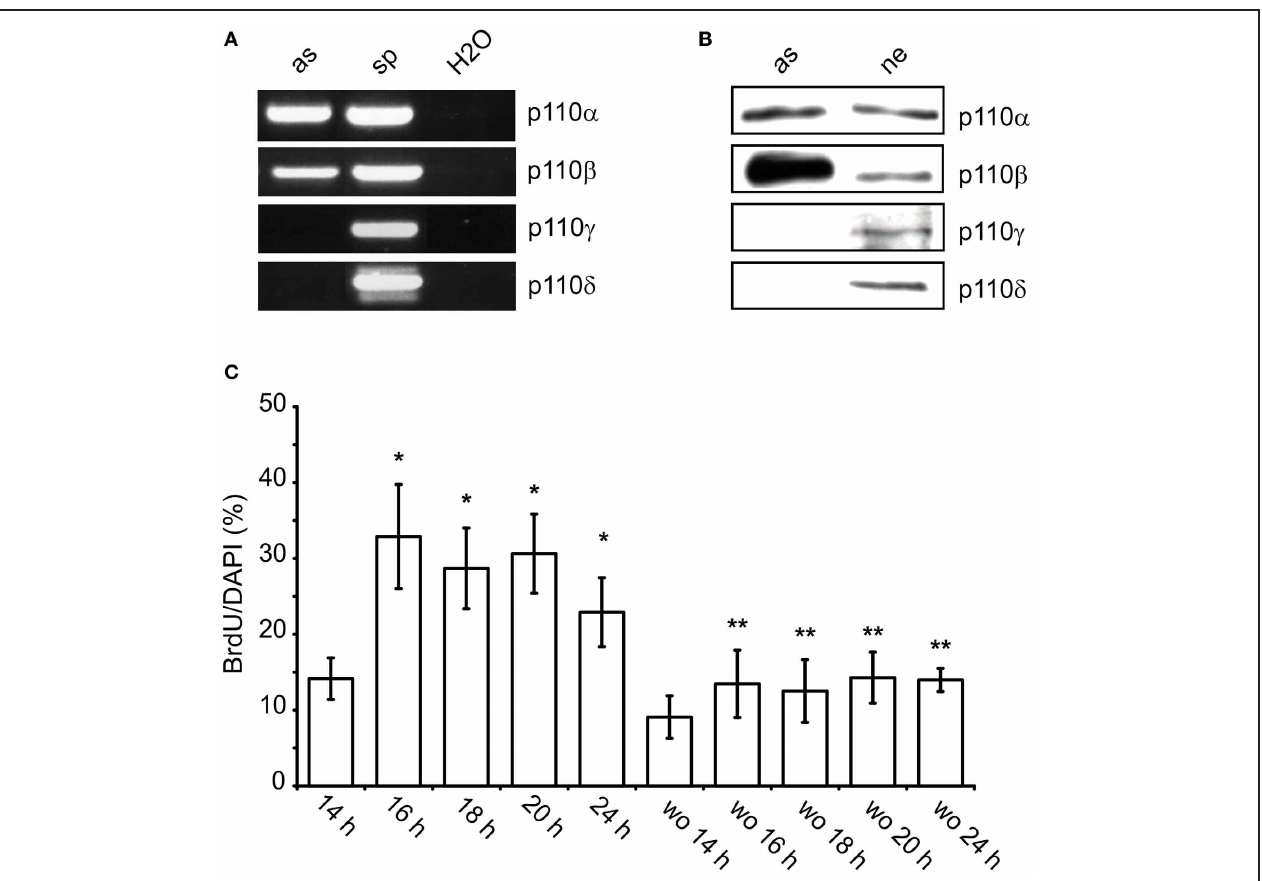
nuclear uptake of BrdU after re-addition of FBS. To astroglial cells FBS-starved for 24h 10% FBS ± wortmannin (100nM, wo) was added for the indicated time periods. BrdU was present during the last hour of incubation with FBS. Means ± CI (0.95) are shown; n ≥ 15; ∗ ∼ p < 0 . 05 compared to 14h, ∗∗ ∼ p < 0 . 05 compared to respective cultures without